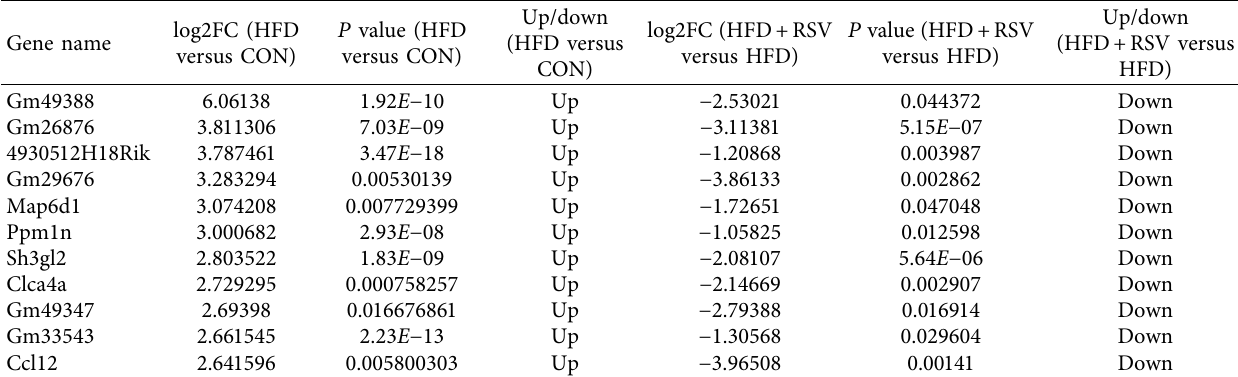
Table 4: Top 30 significantly differential expression mRNAs in